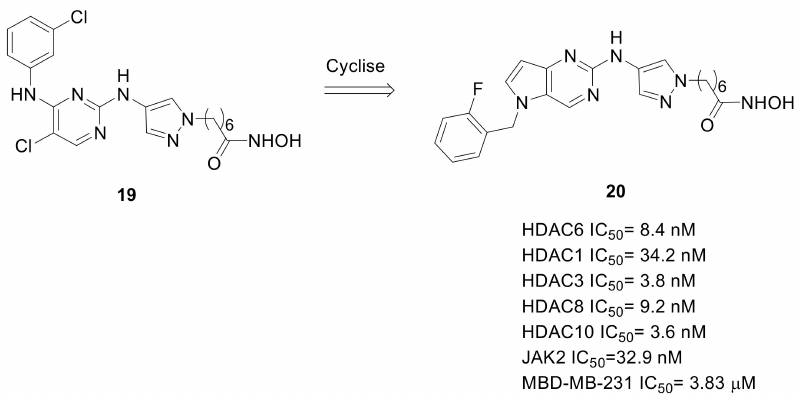
Figure 13. Chemical development of JAK/HDAC dual inhibitors: Structures of compounds 19 and 20 .